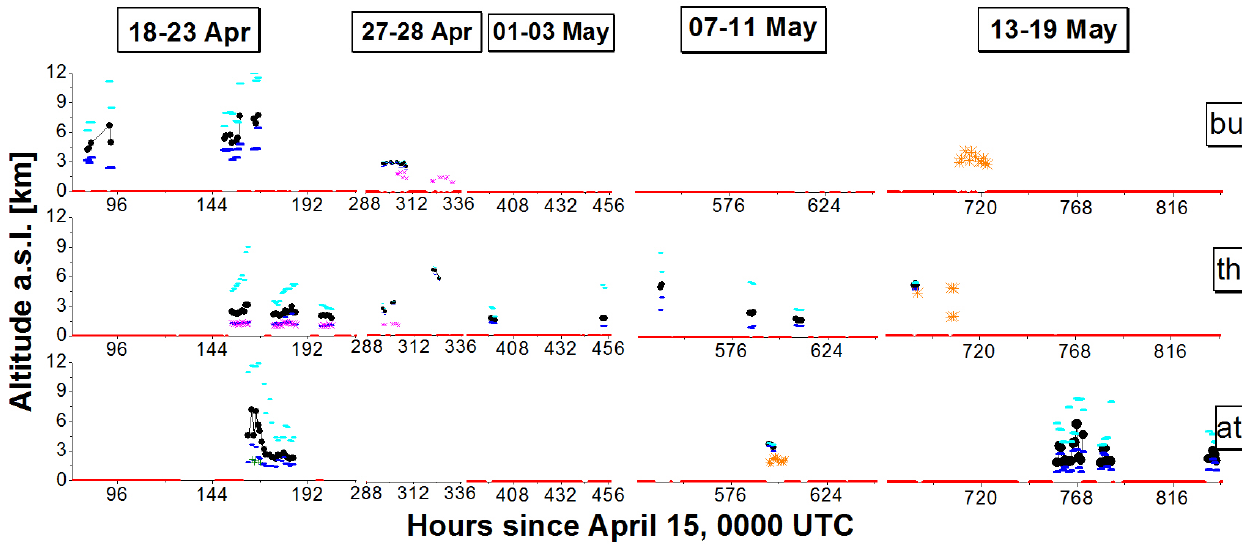
Fig. 8. As Fig. 5 for Eastern Mediterranean cluster: Bucharest (bu), Thessaloniki (th) and Athens (at).